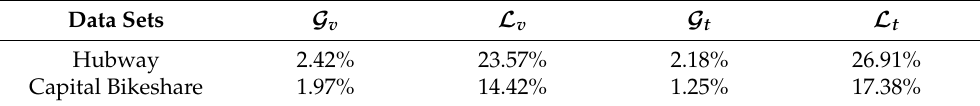
Table 1. Comparison of profit gain and lost demand reduction in a whole day (5 a.m.–12 a.m.).